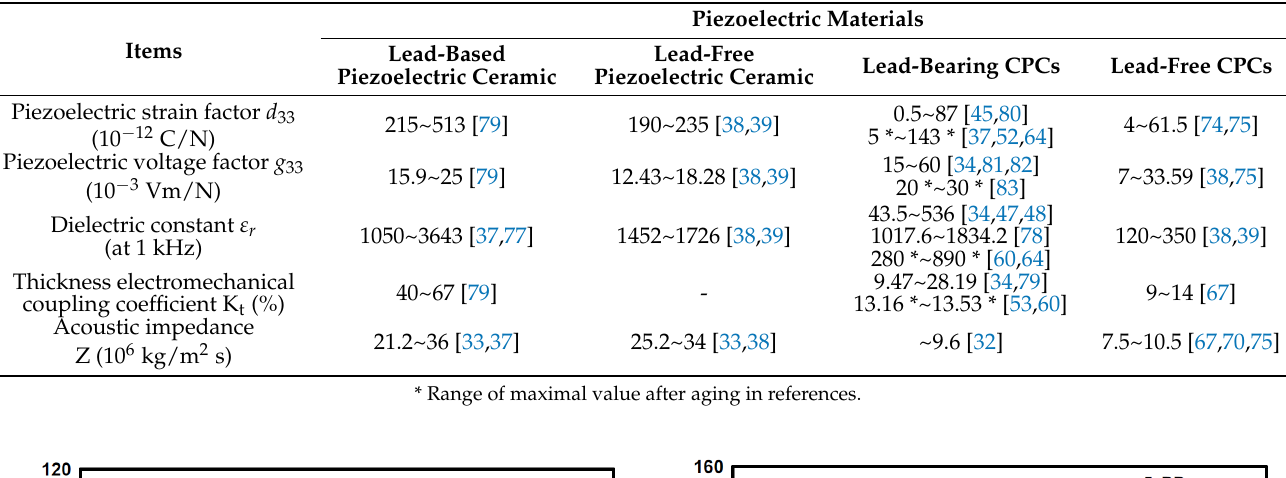
Table 2. Piezoelectric properties of piezoelectric materials.